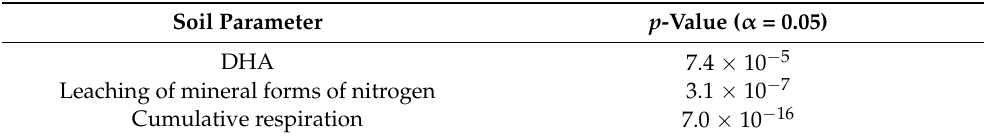
Table 6. ANOVA for the effect of biochar on DHA, leaching of mineral forms of nitrogen, and cumulative